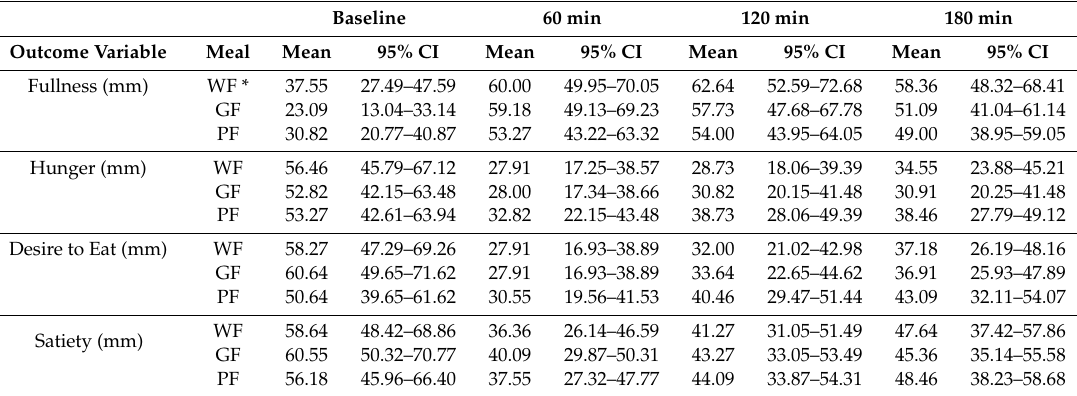
Table 4. E ff ects of meal type on mean values of hunger and satiety rating outcome measurements at baseline and 60, 120, and 180 min in the postprandial period a .